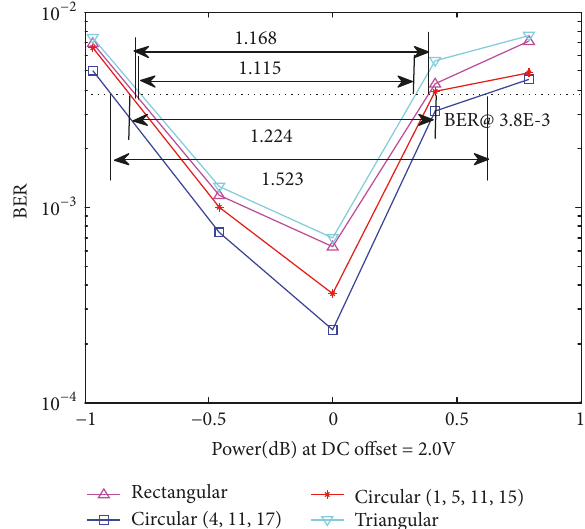
Figure 8: BER versus transmitted electrical power when DC offset is equal to 2.0V.